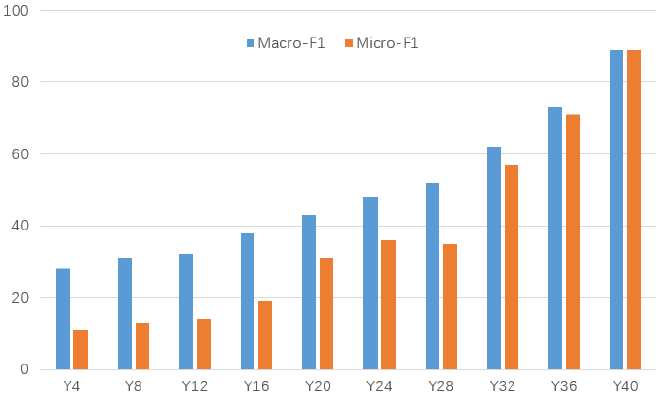
Figure 4. The effect of temporal variation on the classification task on the DBLP dataset.